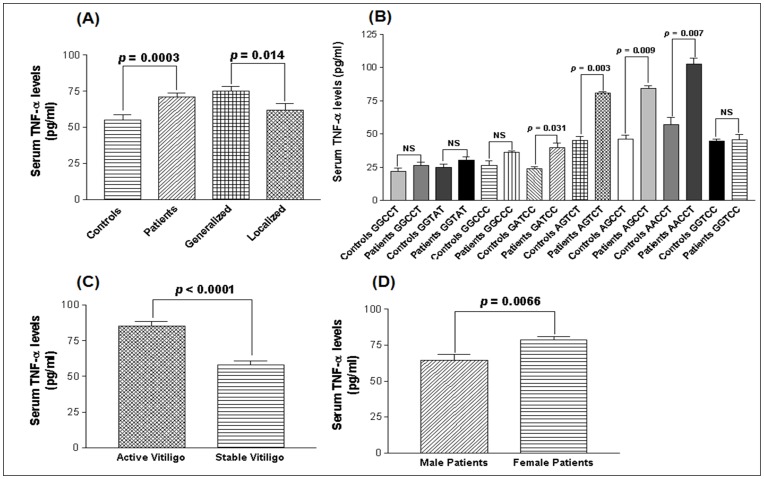
Serum TNF-α levels in controls and vitiligo patients.(A) Comparison of sTNF-α levels (pg/ml) in 236 controls, 214 vitiligo patients, 158 generalized vitiligo patients and 56 localized vitiligo patients, as determined by ELISA. (B). Comparison of sTNF-α levels (pg/ml) with respect to TNF-α promoter haplotypes in 214 vitiligo patients and 236 controls, as determined by ELISA. (C) Comparison of sTNF-α levels (pg/ml) with respect to activity of the disease in 150 patients with active vitiligo and 64 patients with stable vitiligo, as determined by ELISA. (D) Comparison of sTNF-α levels (pg/ml) with respect to gender differences in 97 male patients and 117 female patients with vitiligo, as determined by ELISA.